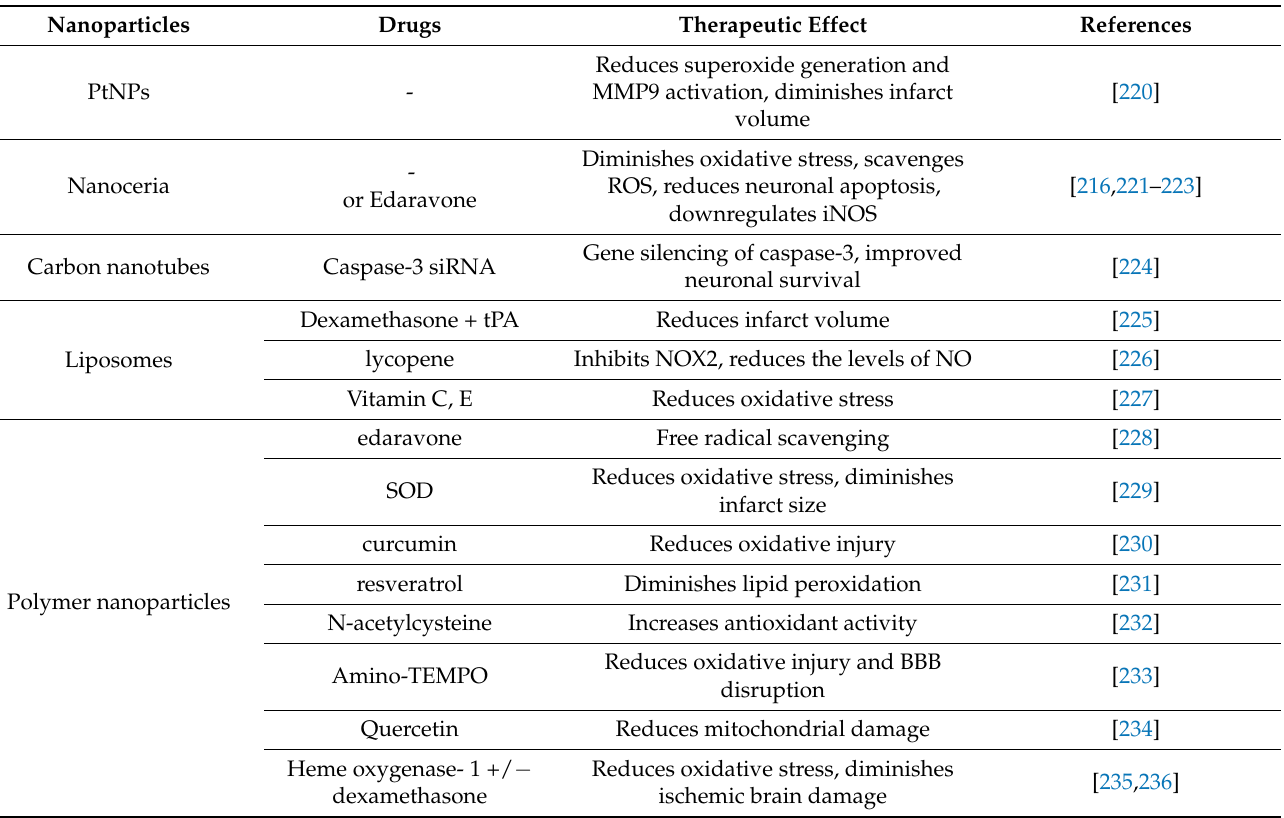
Table 2. Nanomaterials used to target ischemic stroke-induced oxidative stress. Adapted from Song et al. [216] and Dong et al.